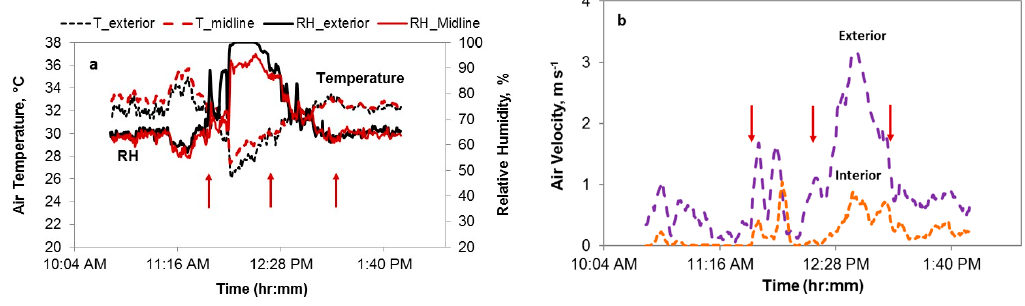
Figure 5. Temperature, relative humidity ( a ) and air velocity ( b ) profiles from interior and exterior logger positions of a summer trip. The first arrow on each graph indicates the beginning of loading, the second the beginning of transport, and the third the beginning of holding period.